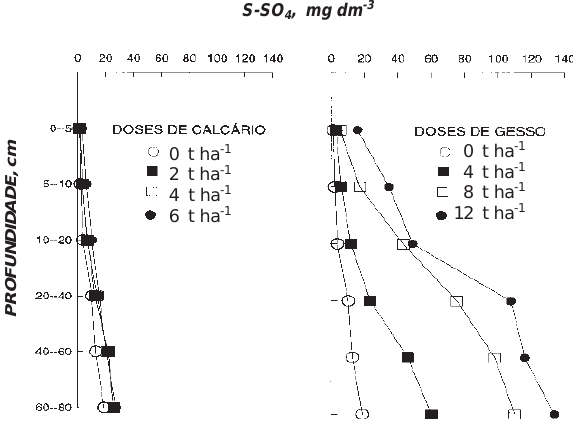
Figura 4. Efeito de doses de calcário, após 28 meses, e de gesso, após 24 meses, sobre os teores de S- SO 4 , em diferentes profundidades. Média de 3